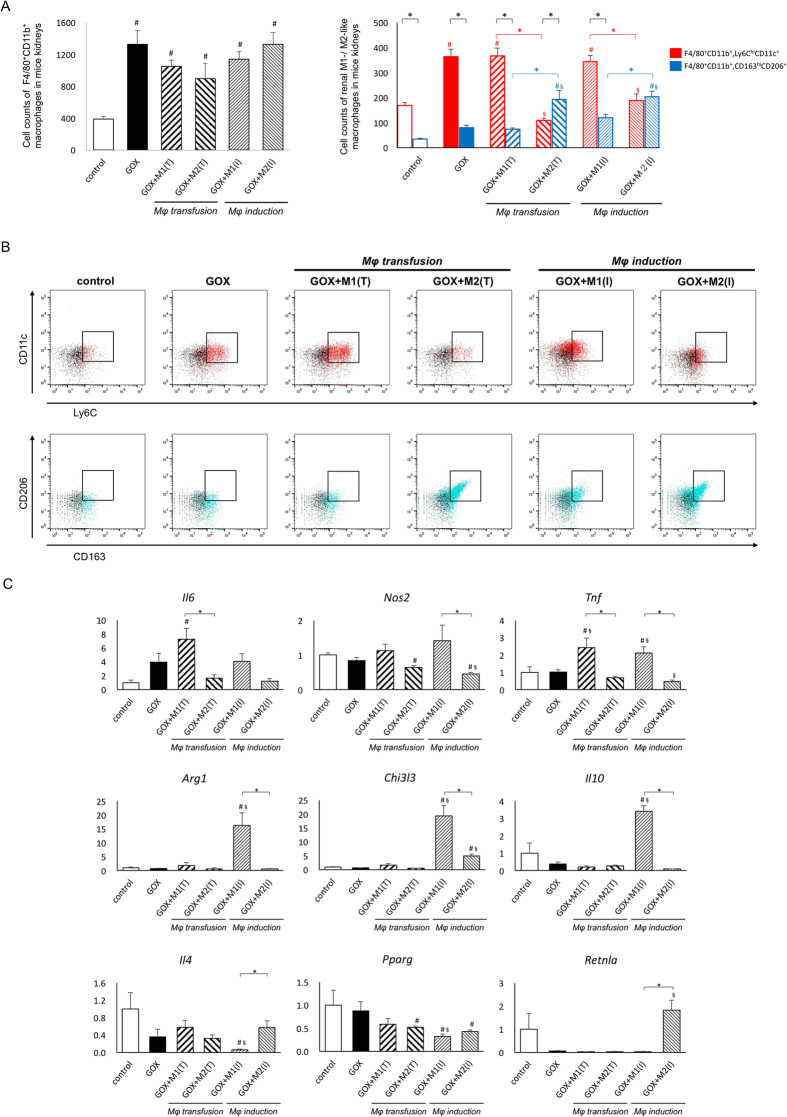
Evaluation of renal macrophages and their related gene expression.(A) Representative bar graphs demonstrate the number of renal F4/80+CD11b+ macrophages (left panel) and quantification of F4/80+CD11b+ Ly6ChiCD11c+M1-like macrophages (red bar) and F4/80+CD11b+CD163hiCD206+M2-like macrophages (blue bar) (right panel). Data are presented as means ± standard errors. N = 4 for each group. *Indicates significant differences between the M1 and M2-like macrophages in the same group (black font) and between M1 and M2 treatment groups (either red or blue font) at p < 0.05; #indicates significant differences compared with the control group at p < 0.05; §indicates significant differences compared with the glyoxylate (GOX)-treated group. The gating strategy for F4/80+CD11b+ cells as pan, F4/80+CD11b+Ly6ChiCD11c+ cells as M1-like and F4/80+CD11b+CD163hiCD206+ cells as M2-like macrophages was described in our previous study23. (B) Representative flow cytometry plots of F4/80+CD11b+Ly6ChiCD11c+ or F4/80+CD11b+CD163hiCD206+ macrophages are shown. (C) The expression of genes was determined by quantitative reverse transcription polymerase chain reaction (qRT-PCR) using TaqMan assays. Control values represent the average of the data for the control group. Data are presented as means ± standard errors. N = 6 for each group. *Indicates significant differences between the M1 and M2Mφ groups in the same treatment at p < 0.05; #indicates significant differences compared with the control group at p < 0.05; §indicates significant differences compared with the glyoxylate (GOX)-treated group. Il6, interleukin 6; Nos2, inducible nitric oxide synthase 2; Tnf, tumor necrosis factor; Arg1, arginase 1; Chi3l3, chitinase 3-like 3; Il10, interleukin 10; Il4, interleukin 4; Pparg, peroxisome proliferator activated receptor gamma; Retnla, resistin like alpha. M1(T) and M2(T) indicate transfusion, whereas M1(I) and M2(I) induction treatment of each macrophage.